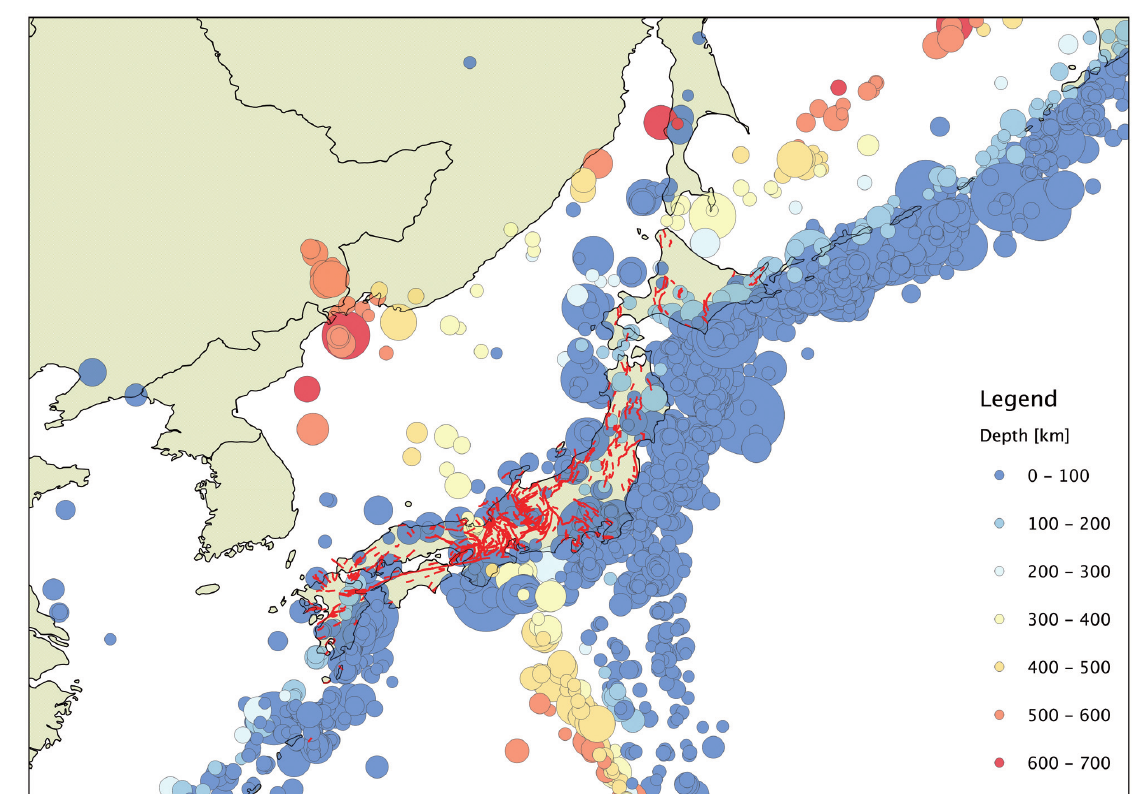
Figure 5. Example of fault section traces included in the GEM Faulted Earth database. Earthquake epicenters belong to the ISC-GEM cat- alogue [Storchak et al. 2013]; the radius of the circles used to represent the epicenters is proportional to the rupture length while the face color indicates the hypocentral depth as explained in the